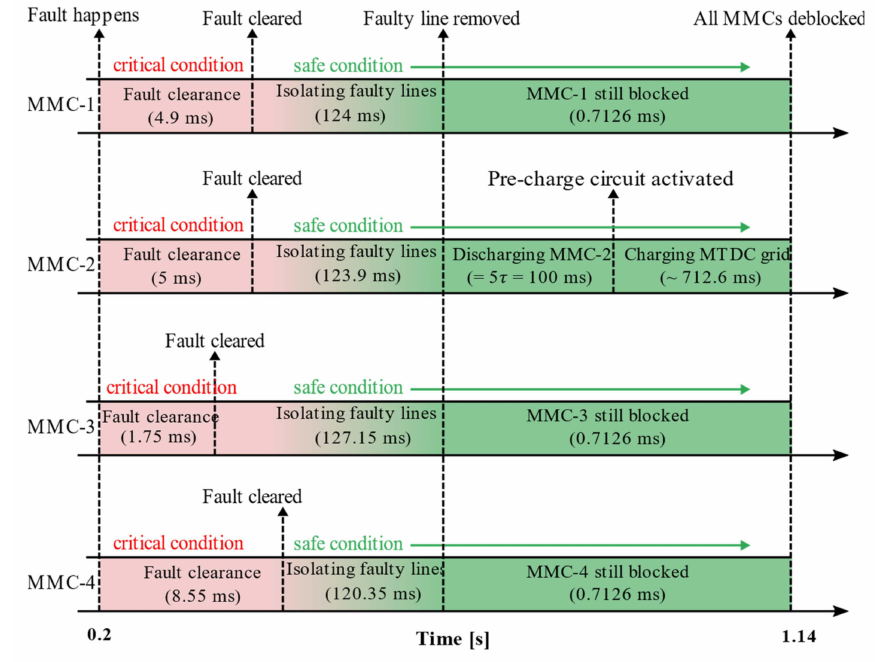
Figure 15. Fault clearance and restoration time of MMCs under DC fault at location F1.